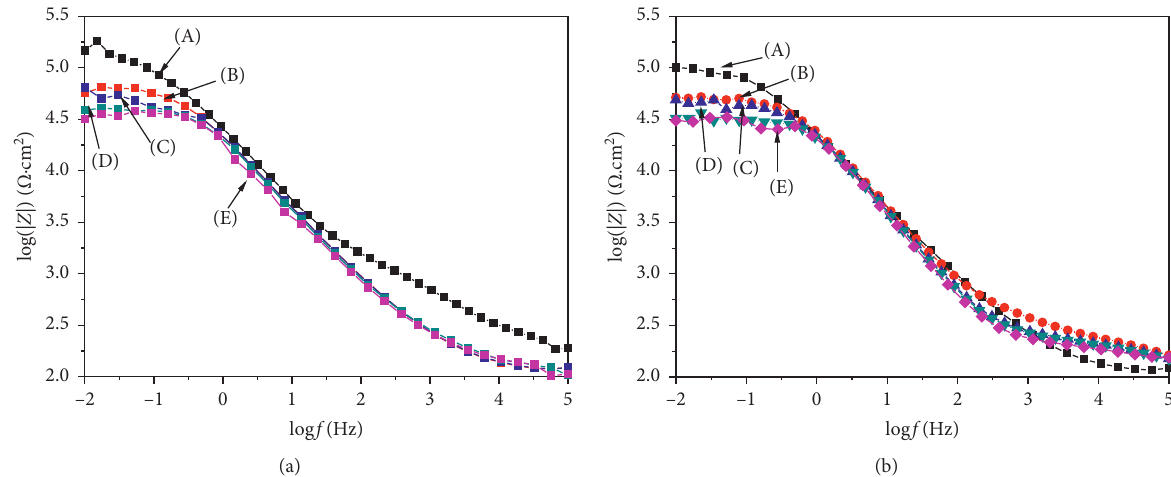
Figure 7: Impedance modulus plots. LDH (a) and LDH-H (b) for various immersion times: (A) 1h, (B) 24h, (C) 72 h, (D)120 h, and (E)